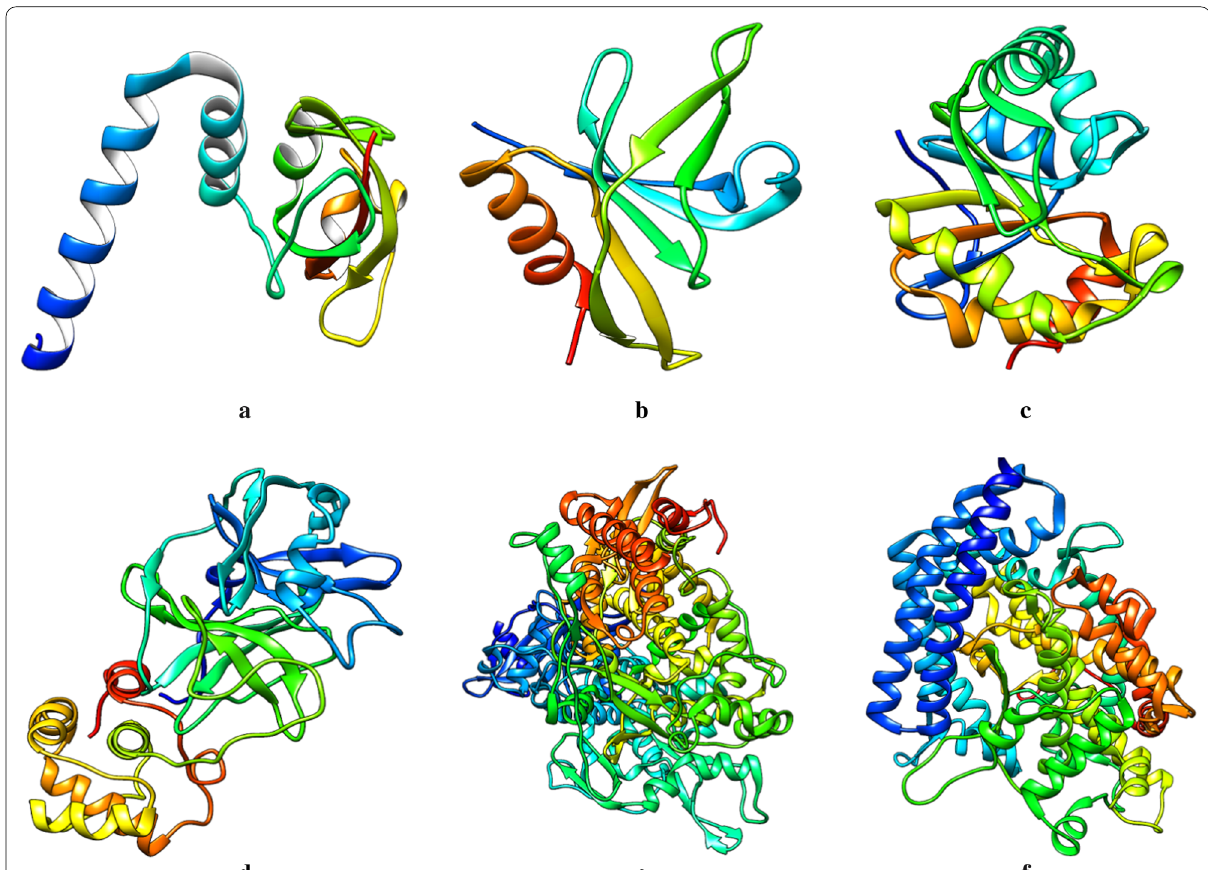
Fig. 1 Crystal structure of prepared molecular targets a Replicase polyprotein 1a. b RNA binding protein of NSP9. c ADP ribose phosphatase of NSP3. d 3-chymotrypsin-like protease. e RNA-dependent RNA polymerase. f Angiotensin-converting